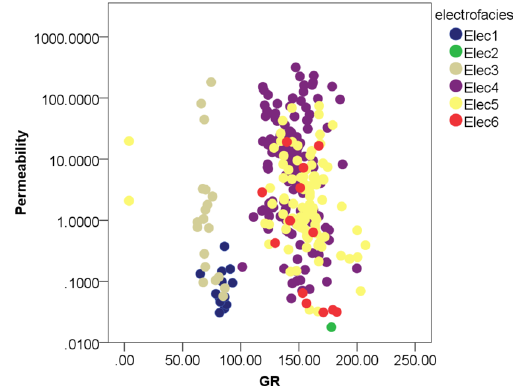
Fig. 12 GR–K crossplot in electrofacies